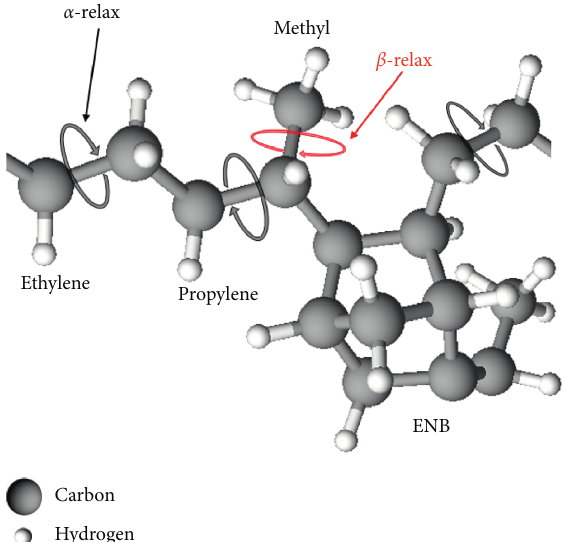
Figure 10: Proposed α and β relaxation processes in the EPDM molecular structure.